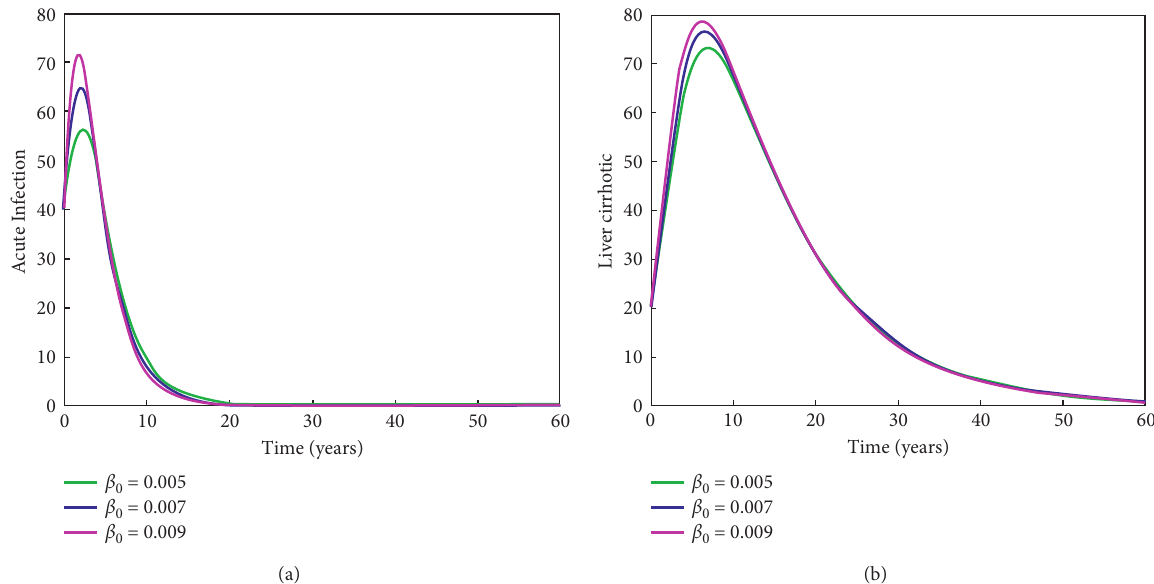
Figure 6: The simulation results of I ( t ) and C ( t ) with respect to various mean transmission coefficient β fixed.